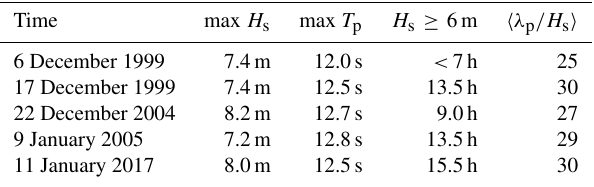
Table 1. The maximum values of the wave parameters during the storms. The exceedance time for the significant wave height over 6m and mean inverse significant steepness for that exceedance time are also